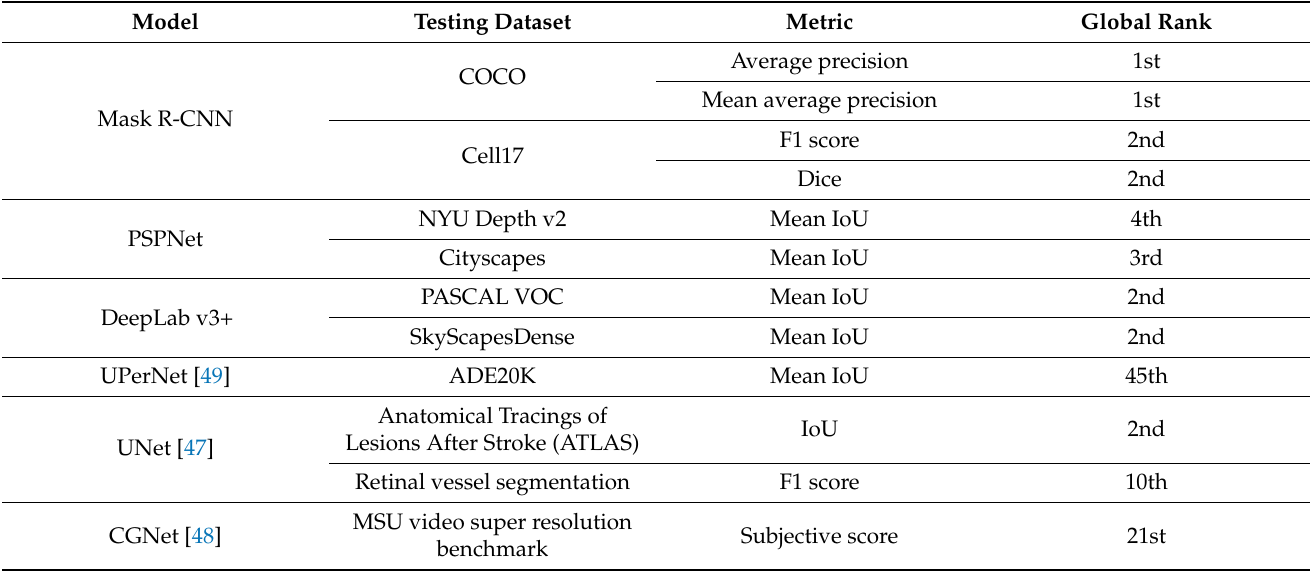
Table 1. Evaluation of algorithms, with their global ranks (data source: Papers with code. https://paperswithcode.com/ (accessed on 27 May 2021)).